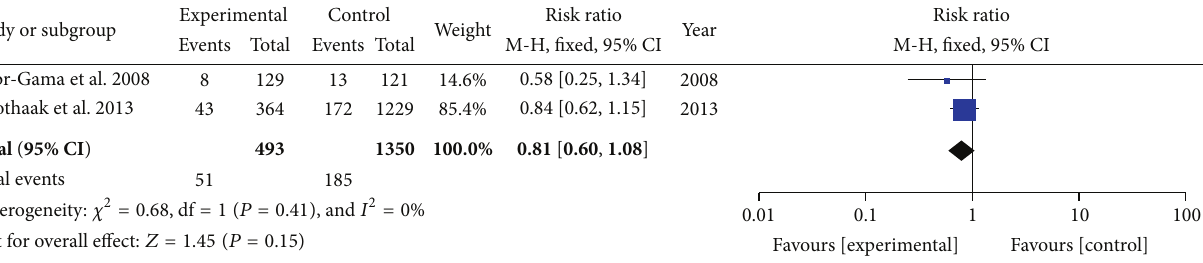
Study or subgroup